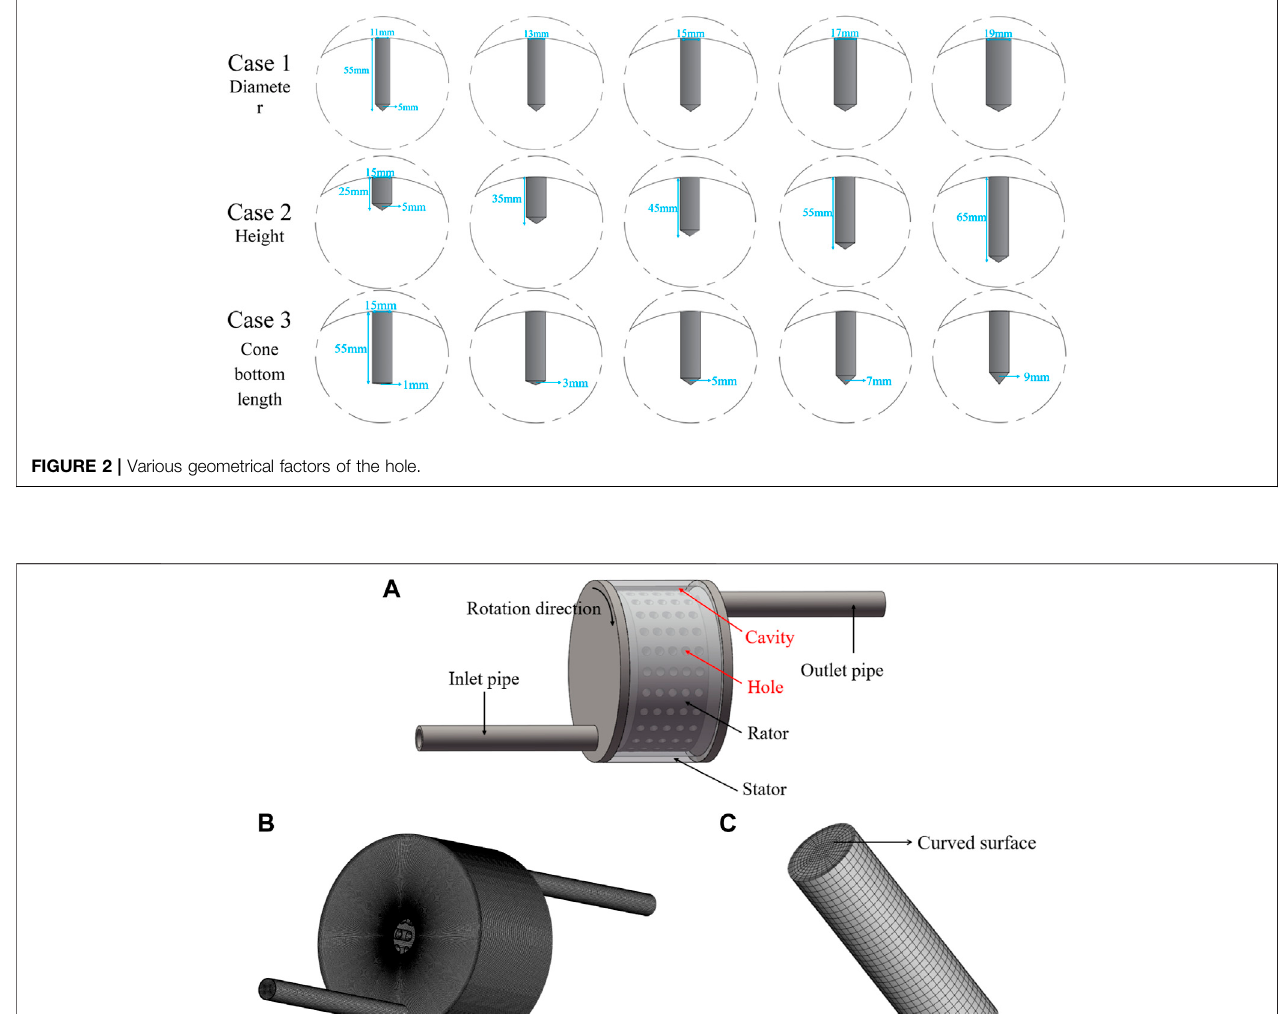
Frontiers in Energy Research |